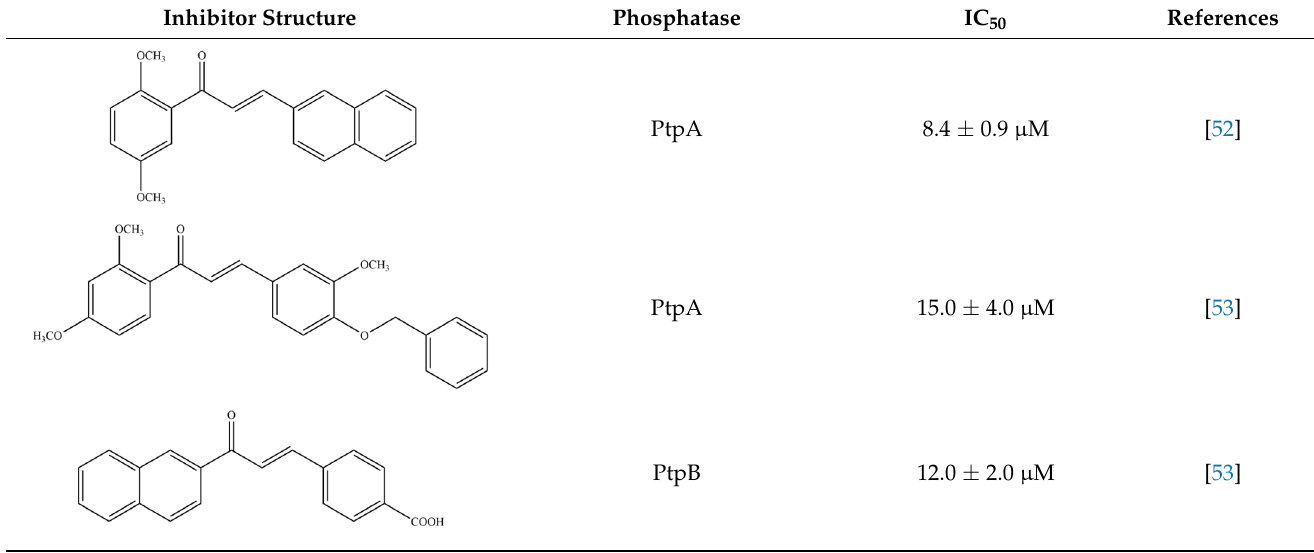
Table 1. Structure of bacterial protein tyrosine phosphatase inhibitors. Inhibitor Structure